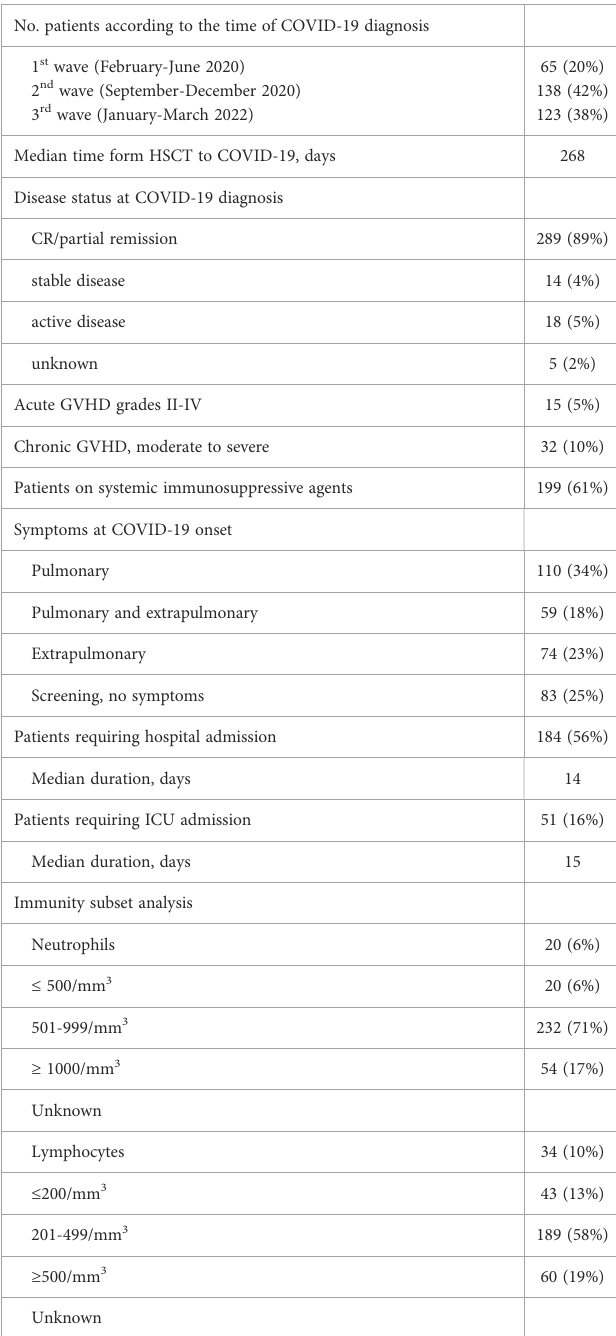
TABLE 2 Patient Characteristics at diagnosis of COVID-19. No. patients according to the time of COVID-19